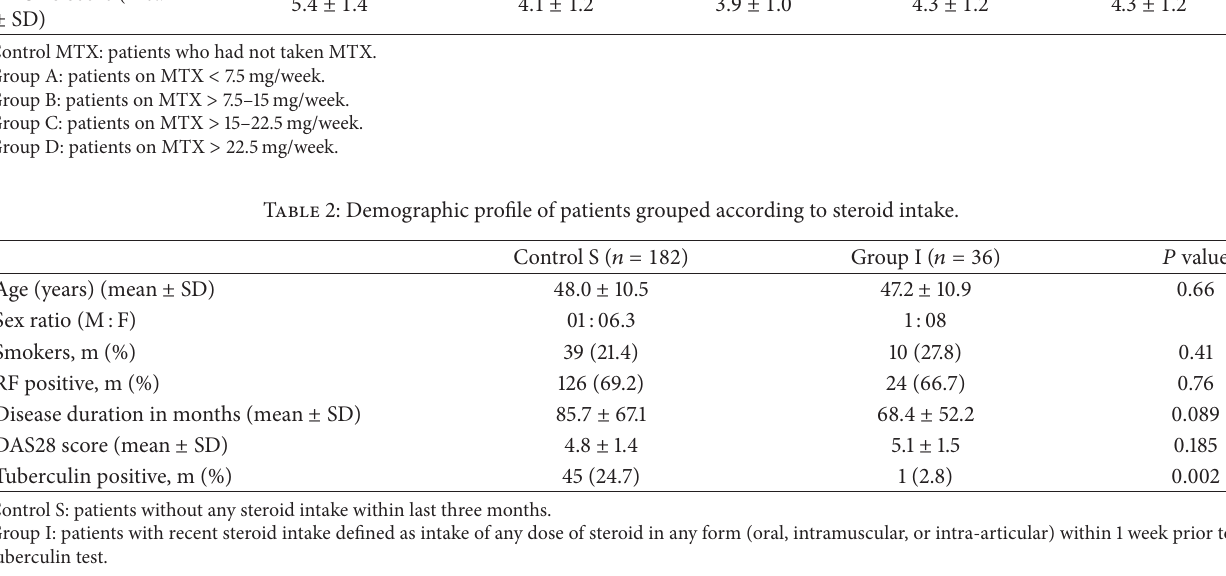
Control S: patients without any steroid intake within last three months. Group I: patients with recent steroid intake defined as intake of any dose of steroid in any form (oral, intramuscular, or intra-articular) within 1 week prior to tuberculin test. Table 3: Comparison of tuberculin sensitivity among patients taking different doses of methotrexate ( 𝑛 = 250 ). Number of patients with TST Dose specific group Confidence interval positivity (%)